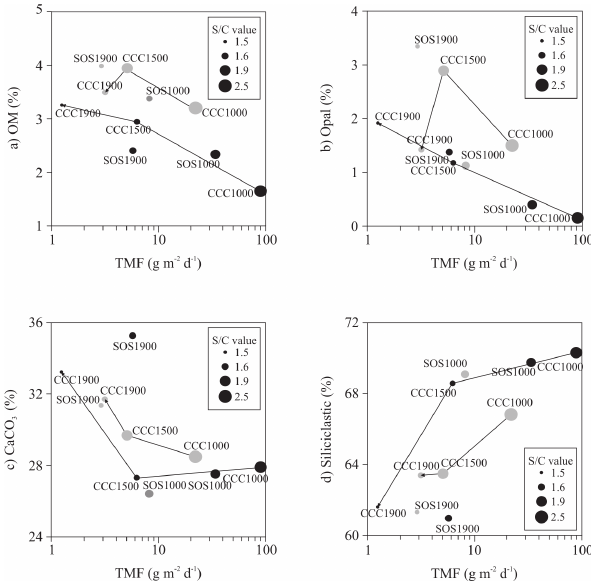
Fig. 7. Content of (a) organic matter (OM), (b) opal, (c) cal- cium carbonate (CaCO 3 ) , and (d) siliciclastic versus total mass flux (TMF) (gm − 2 d − 1 ) of the samples recovered during the maximum arrival of material of each DSWC pulse (first pulse (black dots) and second one (grey dots)). Arrows represent the along Cap de Creus transect. Size of the dot represents the value of the silt/clay ratio